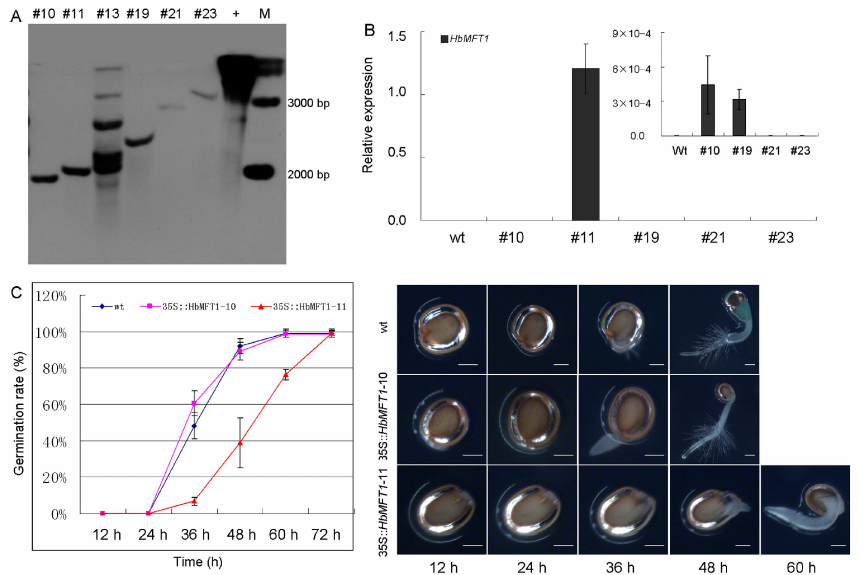
Figure 7. Seed germination comparison between 35S:: HbMFT1 transgenic Arabidopsis and wild-type (wt). ( A ) Southern blot analysis of transgene integration of HbMFT1 ; ( B ) Expression analysis of HbMFT1 in lines transformed with 35S:: HbMFT1 . Values were means ˘ SE from three independent biological replicates; ( C ) Time course of the germination rate after transformation with 35S:: HbMFT1 ; ( D ) Seed germination observation at different developmental periods. Results came from six independent biological replicates. Bar indicates 0.2 mm.